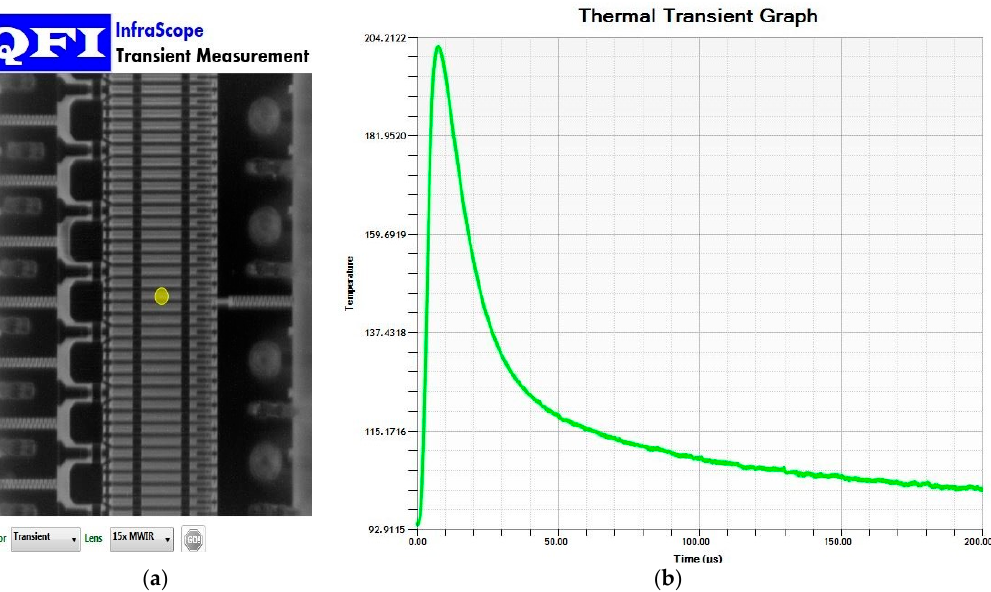
Figure 9. ( a ) The test position of GaN amplifier; ( b ) the transient thermal response of the GaN amplifier under 5 µ s pulse width measured by IR thermal photogrammetry.